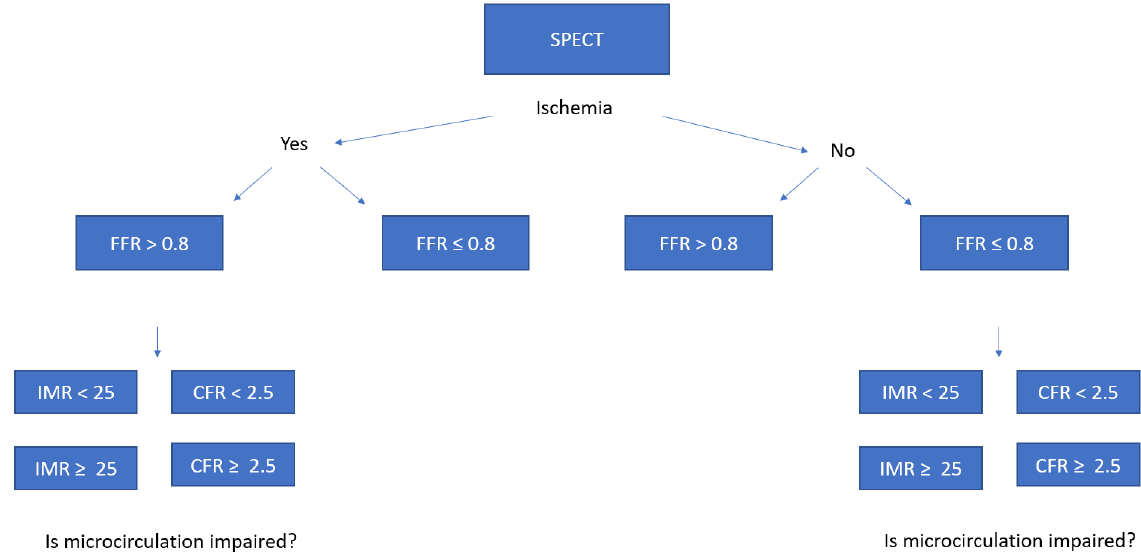
Figure 2. Summary of a second endpoint.